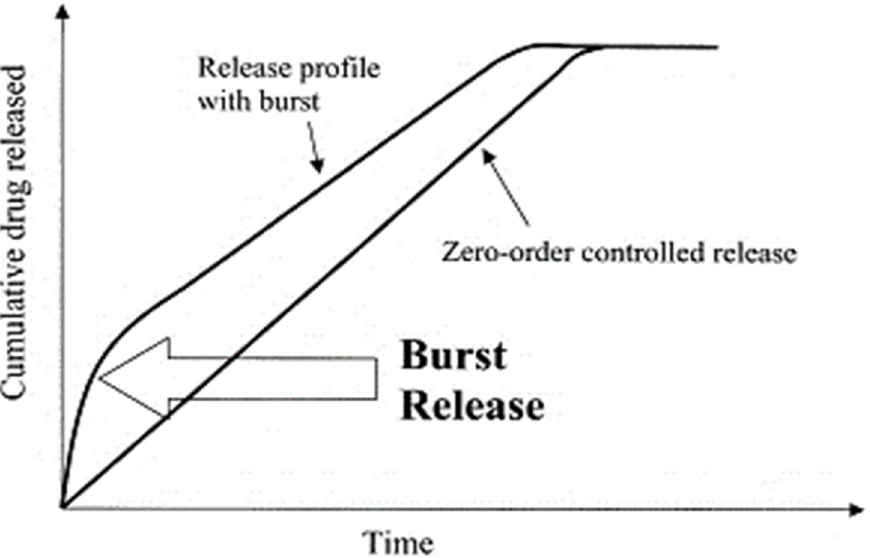
Figure 32. Schematic representing the bursting effect in a zero-ordered drug delivery system. Reproduced with permission from [336].